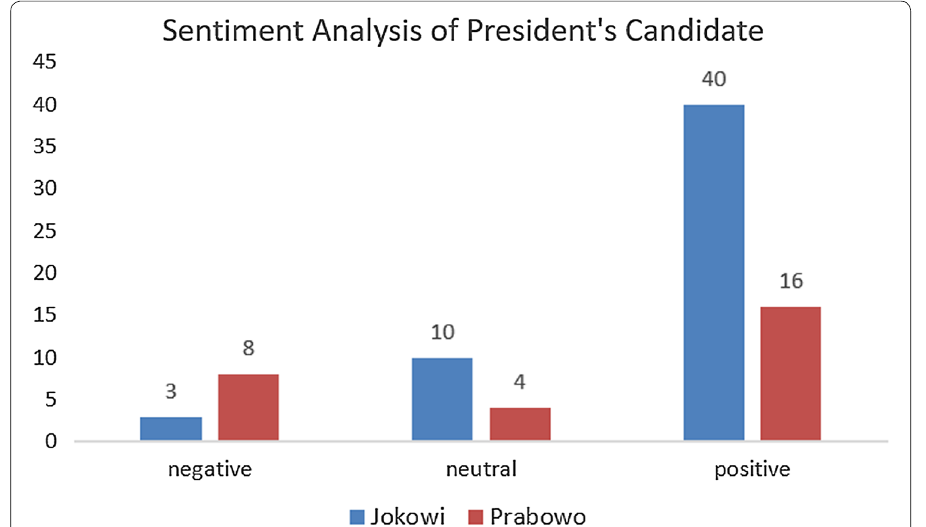
Fig. 6 Sentiment analysis of president candidates based on tweets from popular